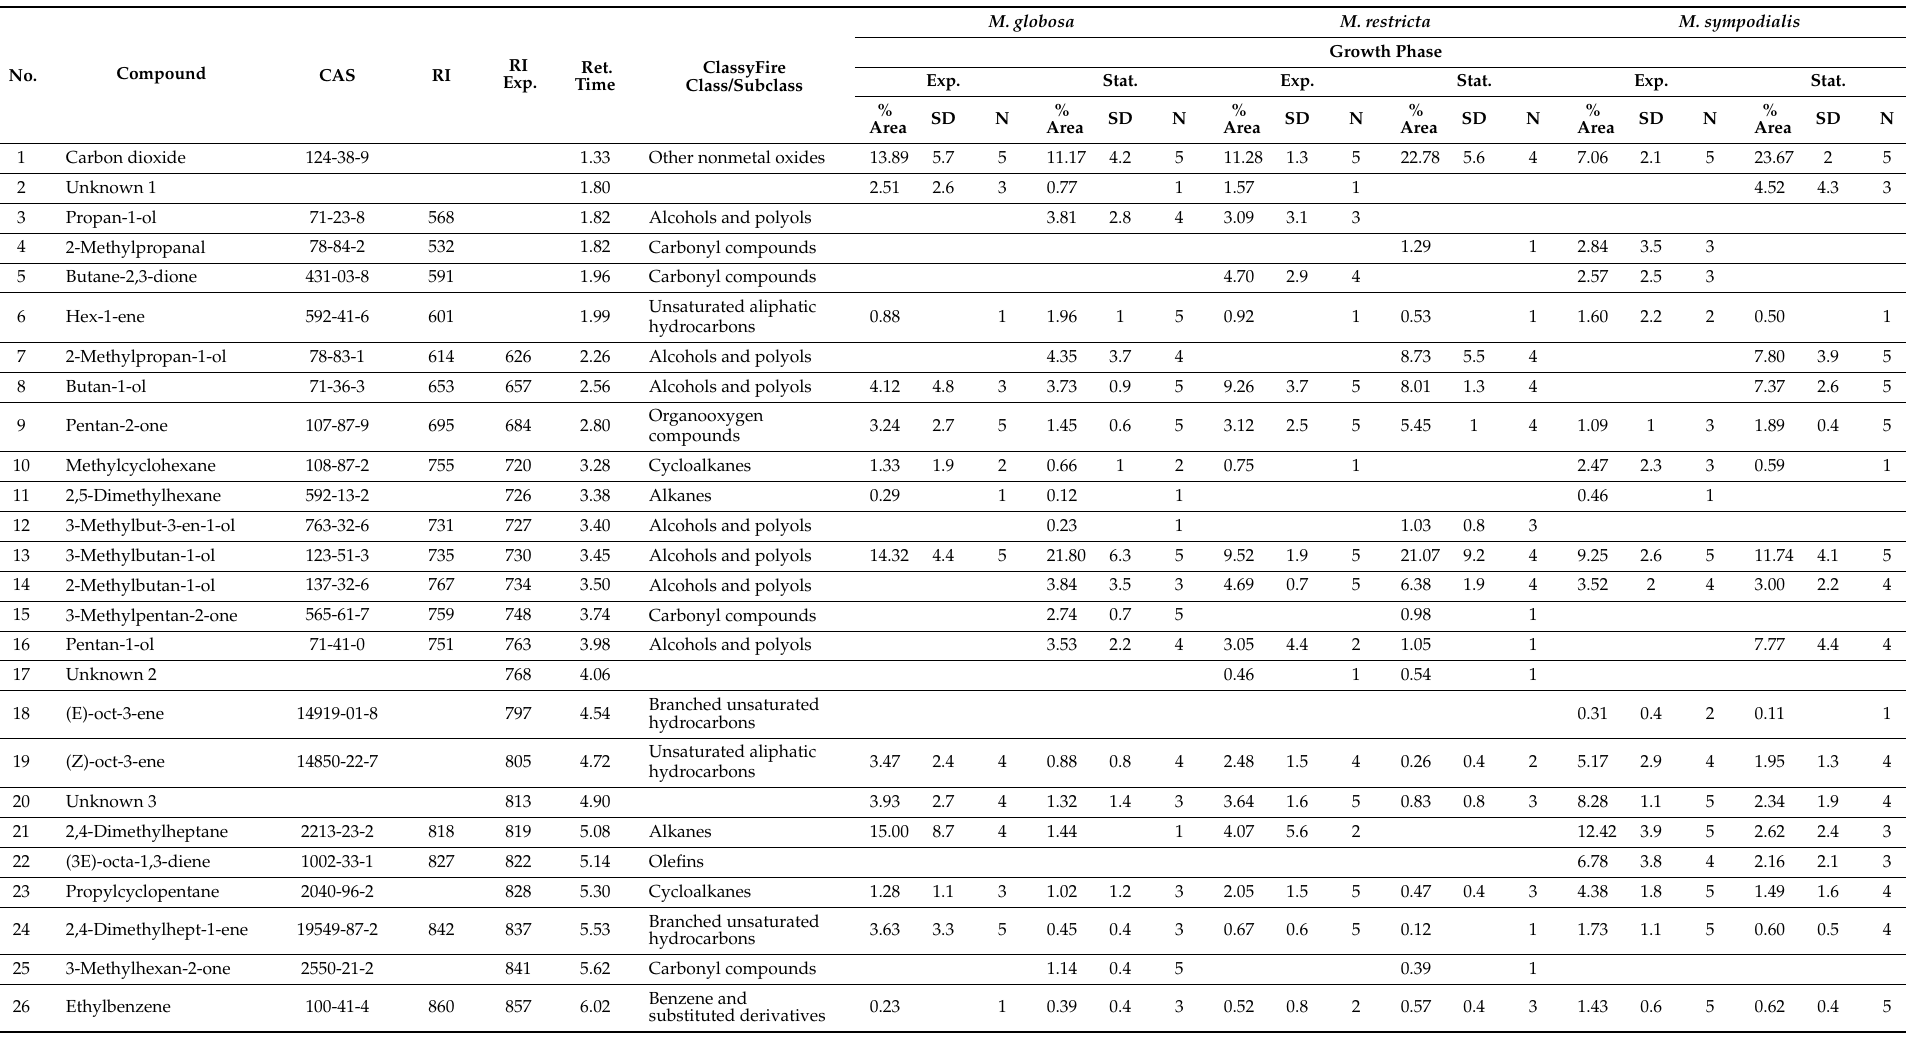
Table 2. Volatile profiles of the three species of Malassezia in the exponential and stationary growth